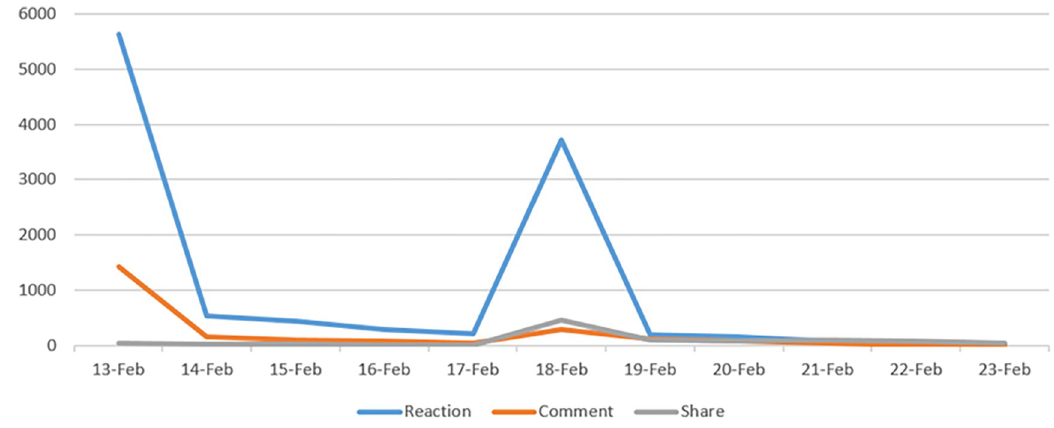
Fig 8. The interactions related to the brand X from 13–23 February 2020. https://doi.org/10.1371/journal.pone.0274596.g008 Table 5. Comparison of factors between the two phases in the campaign.